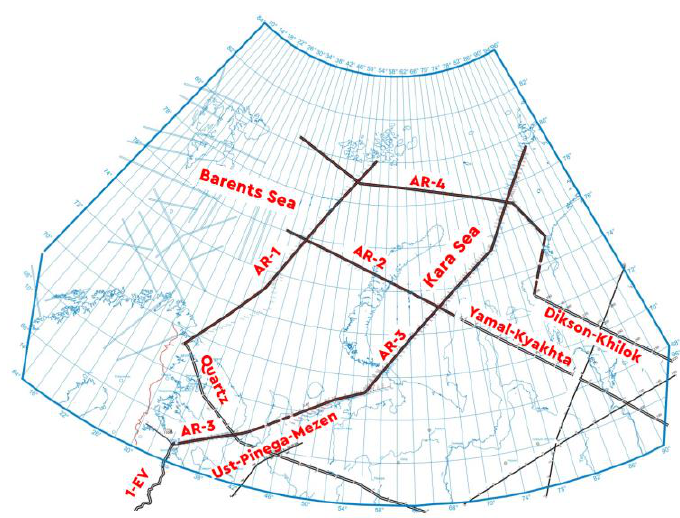
Figure 1. Location of deep seismic profiles in the study area (EV-European, AR – Arctic).